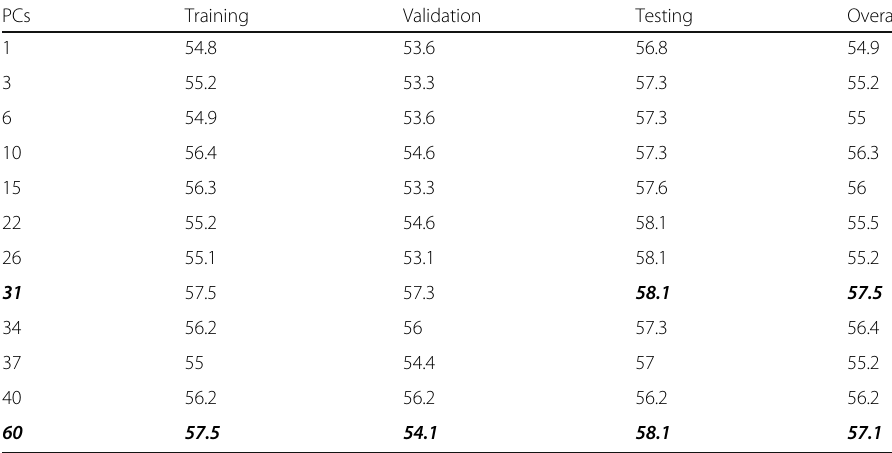
Table 1 The ANN classification results using 12 transformed